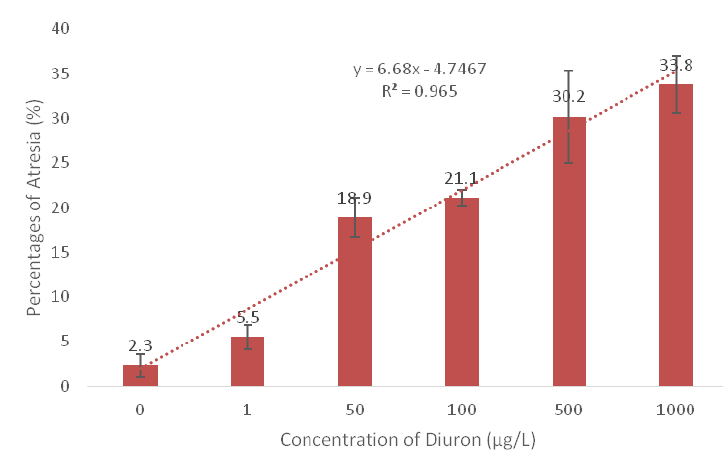
Figure 2. The percentages of atresia of oocytes increases with the trend line of R 2 = 0.965 at dechlorinated water control (0 µ g / L), 1 µ g / L,50 µ g / L,100 µ g / L,500 µ g / L, 1000 µ g / L of Diuron exposure.